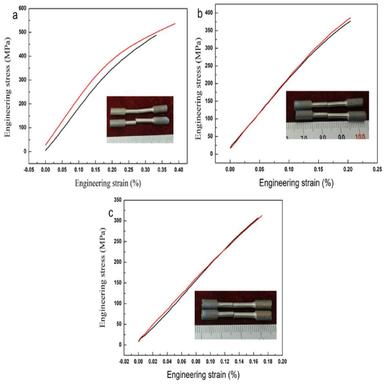
Engineering stress-strain curves of the 0.5 (a), 1 (b), and 2 (c) mm overlap specimens.